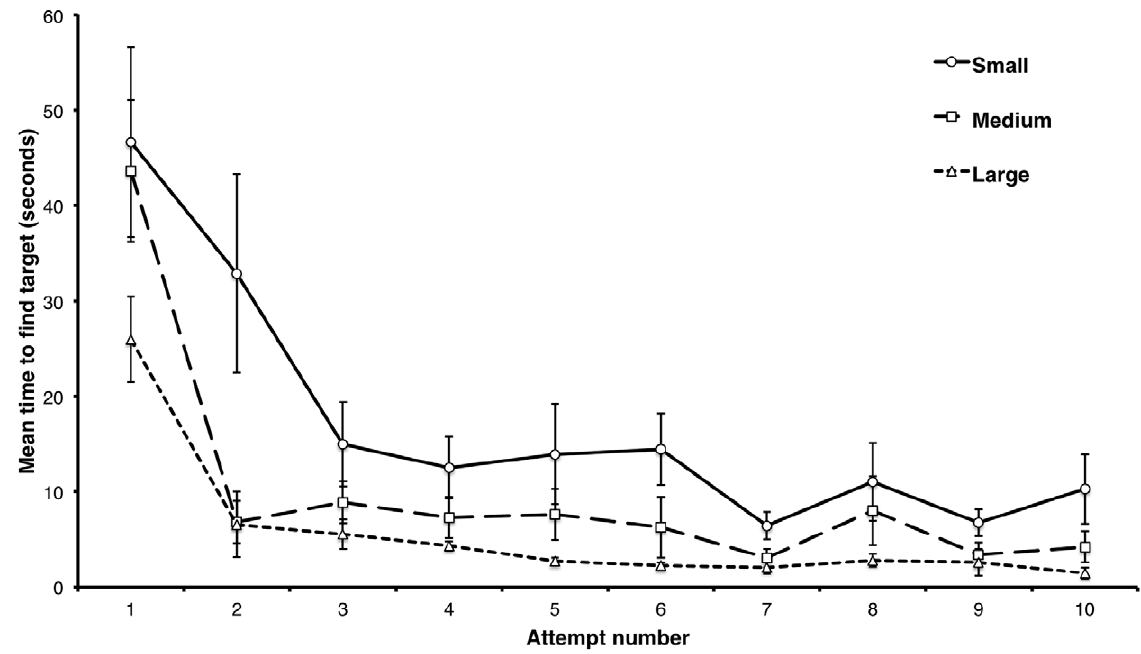
Figure 6. Task difficulty can be calibrated by adjusting target size Performance shown for different targets. Human subjects (N= 29 ).